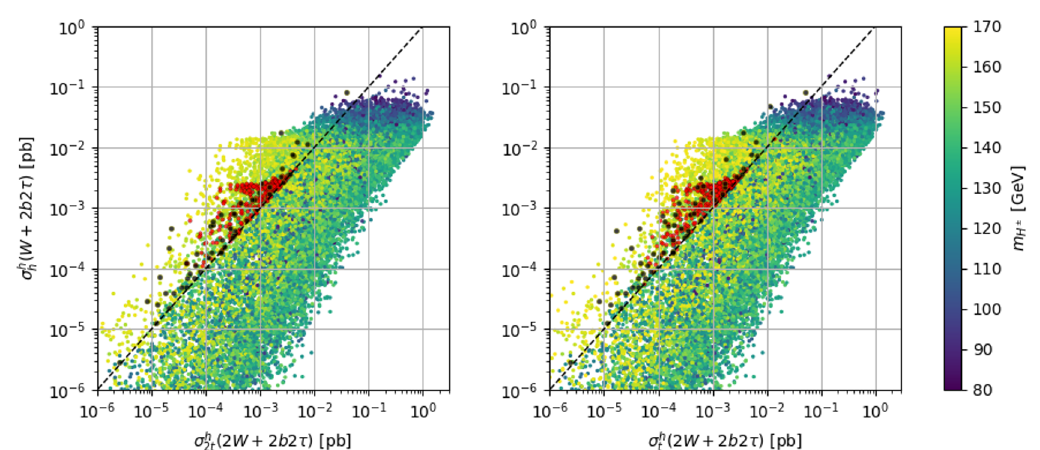
¯ Figure 4 . Values of 2 σ ( pp → H ± h ) × BR( H ± → W ± h ) × BR( h → b b ) × BR( h → τ + τ − ) are ¯ compared with those of 2 σ × BR( t → bH + ) × BR(¯ t → bW − ) × BR( H ± → W ± h ) × BR( h → τ + τ − ) t ¯ t (left) and σ ( pp → t ¯ bH − ) × BR( t → bW +) × BR( H ± → W ± h ) × BR( h → τ + τ − ) (right). The red points identify the values of σ ( H + H − ) × BR( H ± → W ± h ) 2 × BR( h → b ¯ b ) × BR( h → τ + τ − ) which also exceeds those of the latter two top mediated processes, respectively. The colour bar denotes the mass of the charged Higgs boson. Results are for the 2HDM Type-I with the exception of the black points, which refer to the 2HDM Type-X rates for σ ( pp → H ± h ) × BR( H ± → W ± h ) × BR( h → τ + τ − ) 2 .